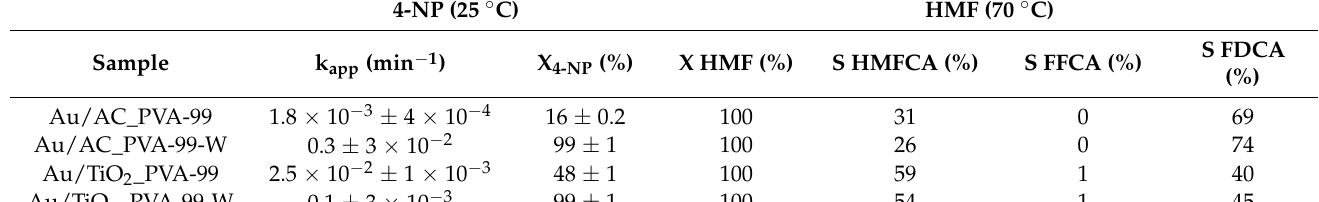
Figure 11. Kinetic performances in 4-NP reduction with the washed and unwashed catalysts prepared using different supports (active carbon and titania). Table 2. Kinetic data for gold nanocatalysts washed and unwashed supported on activated carbon and titania.